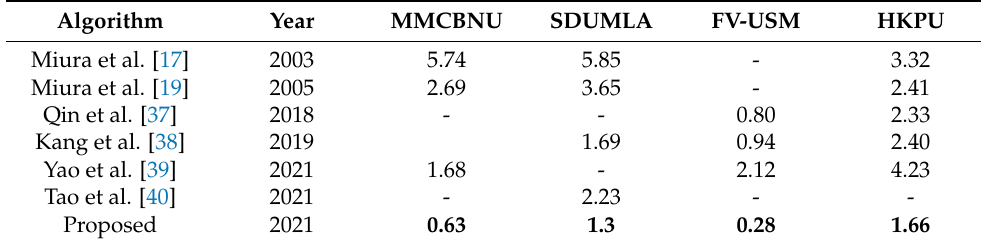
Table 6. Performance comparison in terms of EER (%).